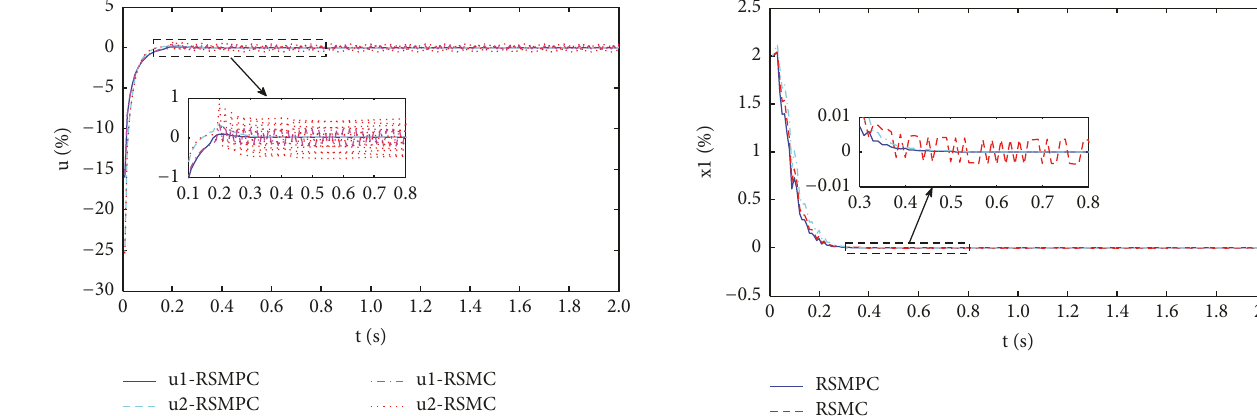
Figure 4: Evolution of sliding surfaces with different controllers.